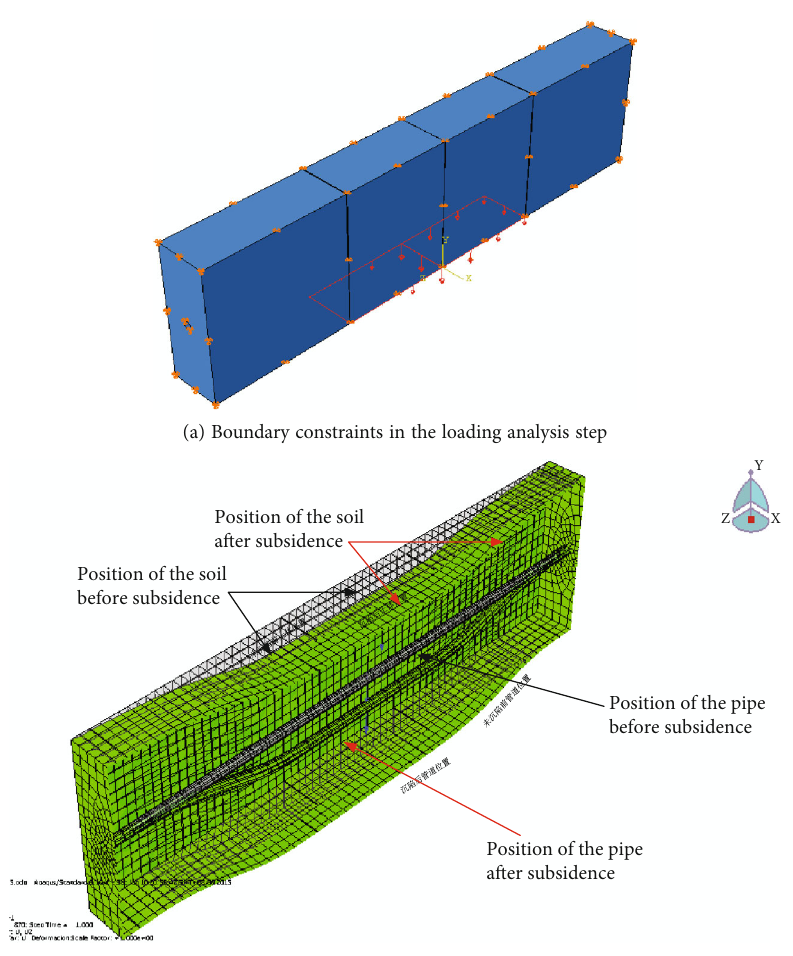
Figure 5: Boundary conditions and loading of model.